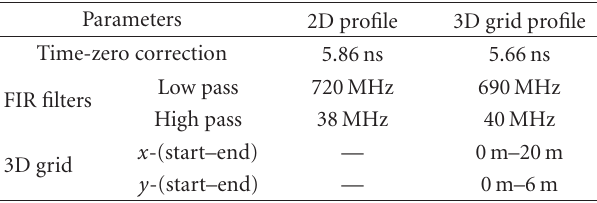
Table 2: Data processing parameters used for 2D and 3D GPR profiles across Hajipur Fault